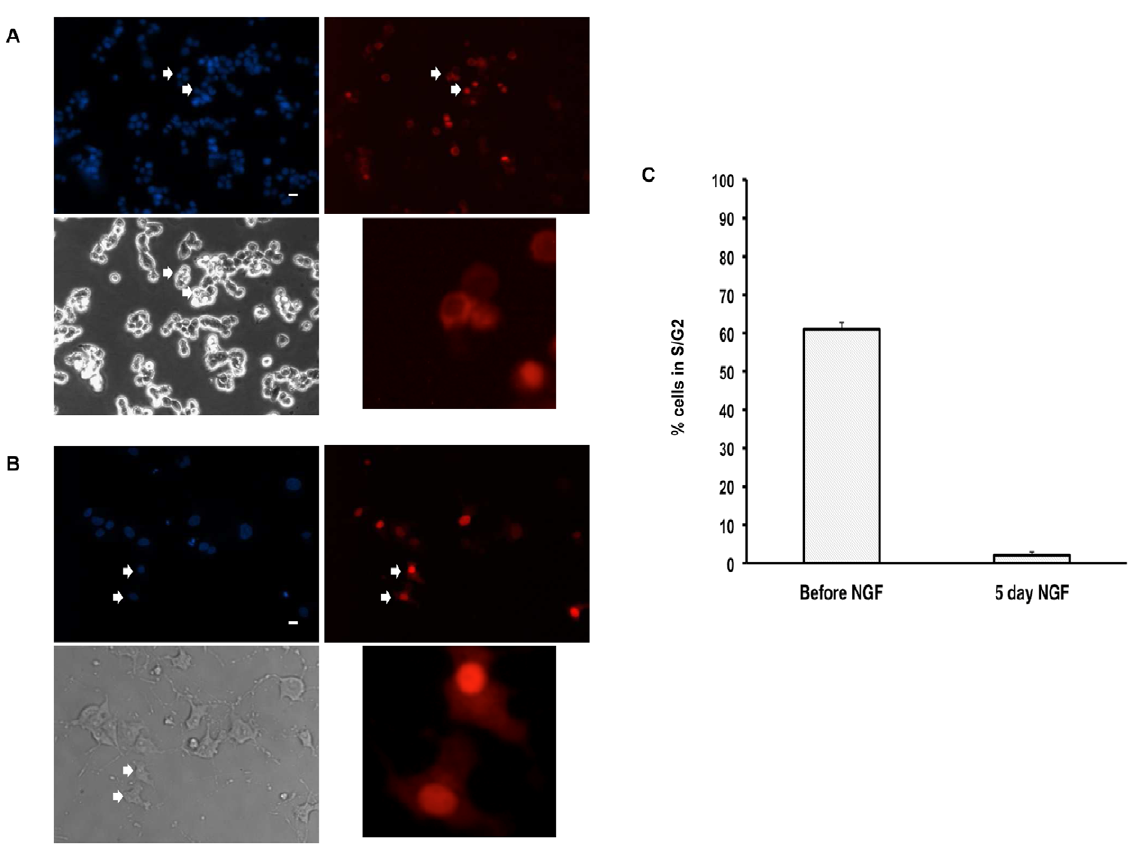
Figure 3. Quantification of S/G2 cells in untreated and NGF-treated LNCX-HDHBc-tdimer2-transduced PC12 cells. LNCX-HDHBc- tdimer2-transduced PC12 cells were plated into Matrigel-coated 4-well chamber slides, and left untreated for two days (No NGF; Figure 3A) or treated with 100 ng/ml NGF for 5 days to allow full differentiation (Plus NGF; Figure 3B). Photodocumentation was at 20 6 after staining with DAPI for nuclear visualization by epifluorescence (blue), by phase contrast for cell visualization (black-and-white) or for nuclear or cytoplasmic HDHBc-tdimer2 visualization by epifluorescence (red). A . Arrows indicate an example of one cell (upper) in which fluorescence is excluded from the nucleus (S1 phase), and one (lower) in which fluorescence is restricted to the nucleus (G1 phase) in proliferating (No NGF) PC12 cells. Scale bar=10 m m. Panel at lower right presents higher magnification of cells indicated by arrowheads immediately above. B . Arrows indicate two cells in which fluorescence is restricted to the nucleus (G1 phase) in differentiated (Plus NGF) PC12 cells. Scale bar=10 m m. Panel at lower right presents higher magnification of cells indicated by arrowheads immediately above. C . Percentage of cells with nuclear exclusion (versus sum of nuclear-excluded and nuclear-localized cells) is plotted for No NGF and Plus NGF